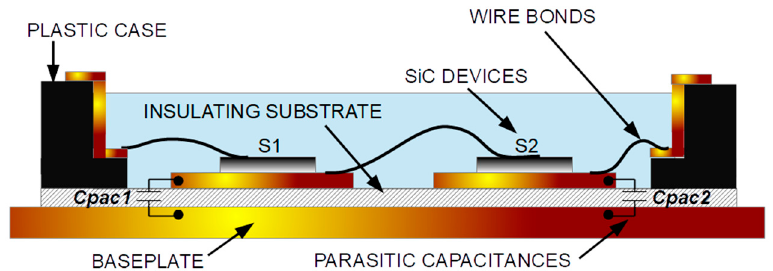
Figure 1. Cross-section of a simplified standard 2D planar package with two dies connected in series [13].